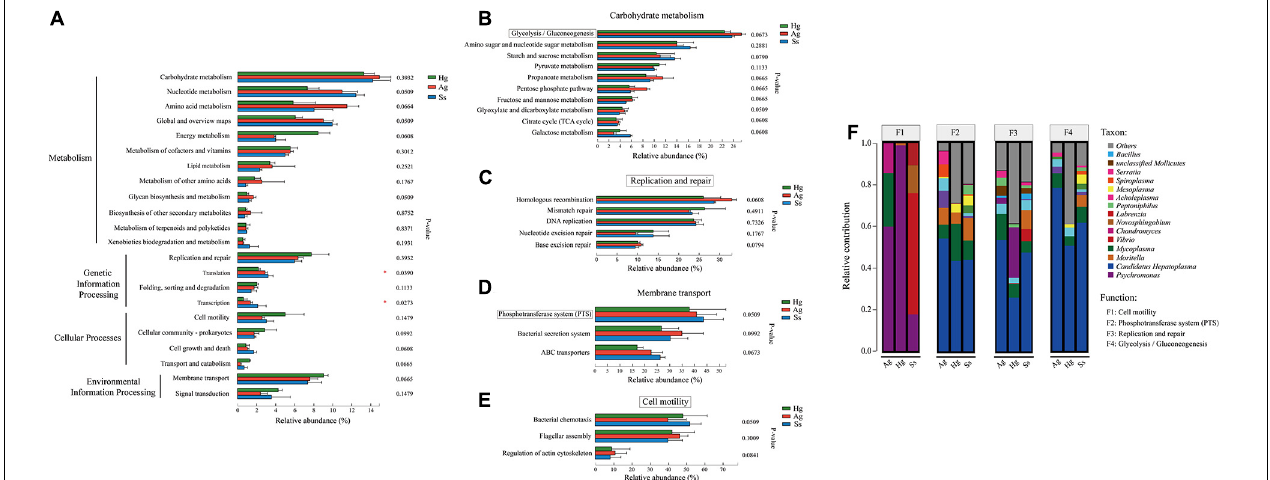
FIGURE 4 | Functional composition and comparison of hadal amphipod gut microbiomes. (A) KEGG classification of total non-redundant protein-coding genes from all intestinal samples. “Metabolisms,” “Genetic Information Processing,” “Cellular Processes,” and “Environmental Information Processing” were most presented functions at KEGG Level 1 pathway (SEED1). Rightmost is P -value. (B–E) Most presented KEGG level 2 pathways (SEED2) among four SEED1 categories [shown in panel (A) ], “Carbohydrate Metabolism,” “Replication and Repair,” “Membrane Transport,” and “Cell Motility,” respectively. Extended error bar plot showed differences of functional categories at KEGG level 2 between three hadal amphipod species. Different colors indicate different groups. Rightmost is P -value: * P < 0.05. Four KEGG pathways, “Glycolysis/Gluconeogenesis,” “Replication and Repair,” “Membrane Transport” (PTS), and “Cell Motility,” marked in red box, were selected out for Species Contribution Relationship Analysis. (F) Species and functional contribution analysis. Species contribution relationship of four KEGG functional categories at gene